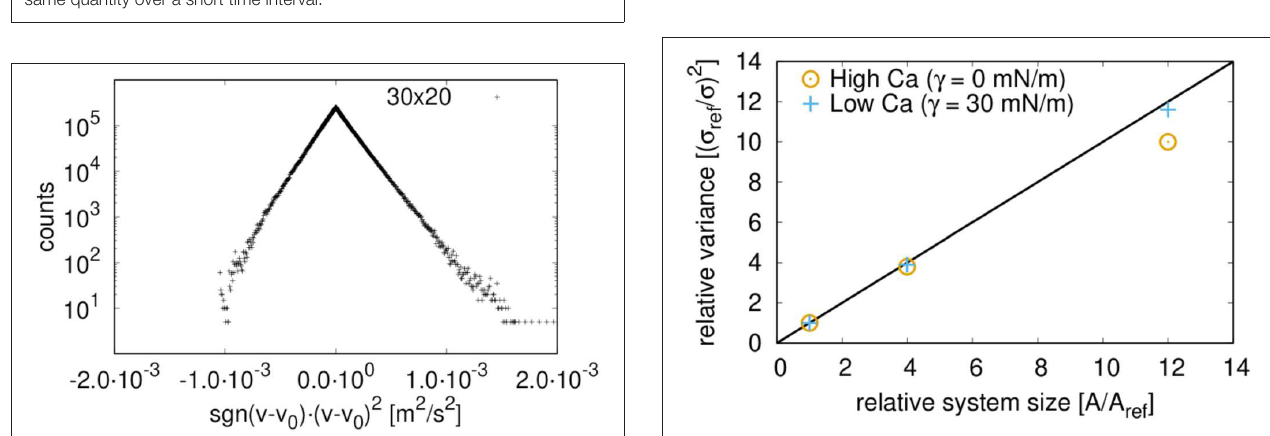
FIGURE 5 | Scaling of the variance σ 2 of the flow velocity size distributions with system size. cases, (A) and (B), an REV can be defined for a range of